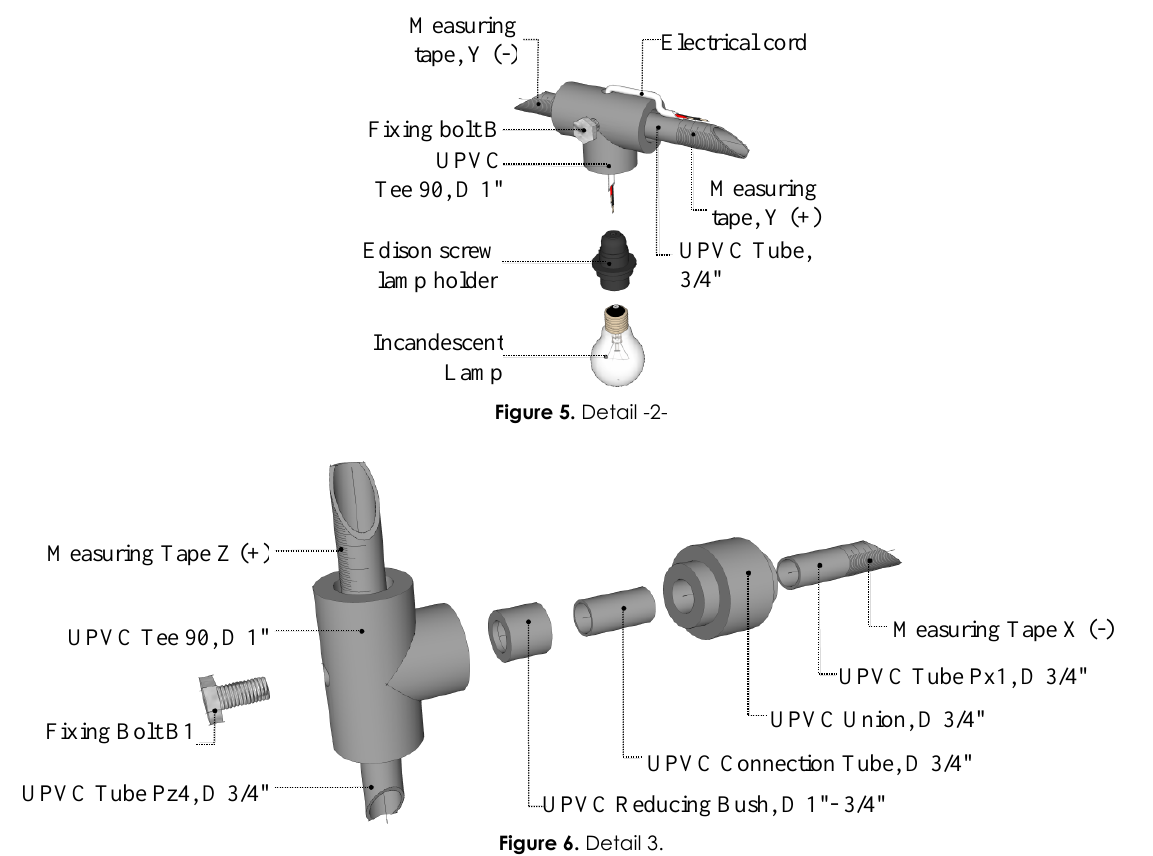
Figure 6. Detail 3.